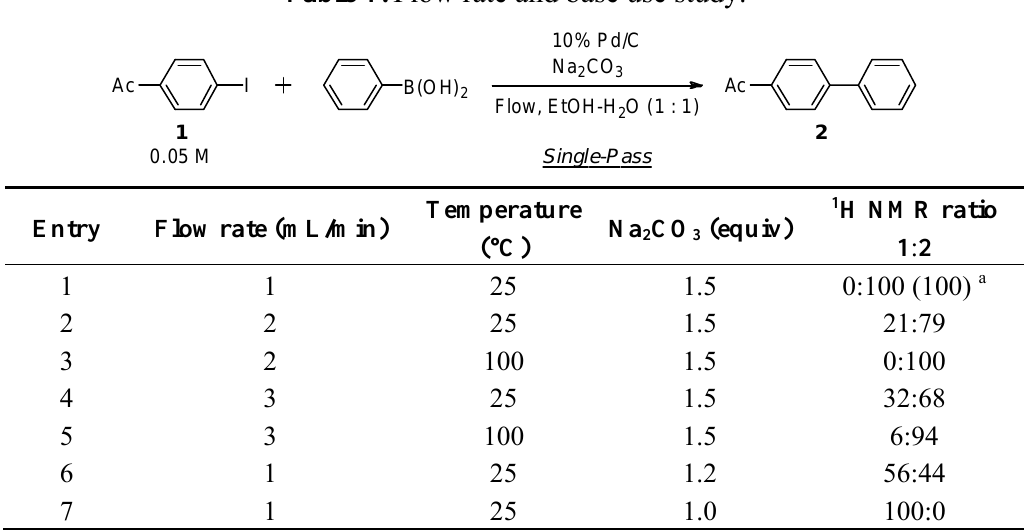
Table 1. Flow rate and base use